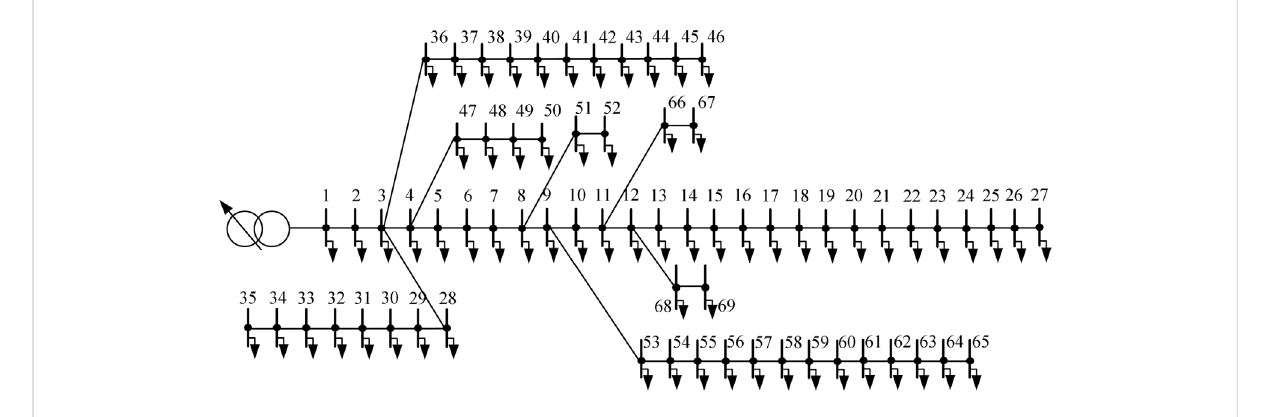
FIGURE 2 IEEE 69-node distribution network